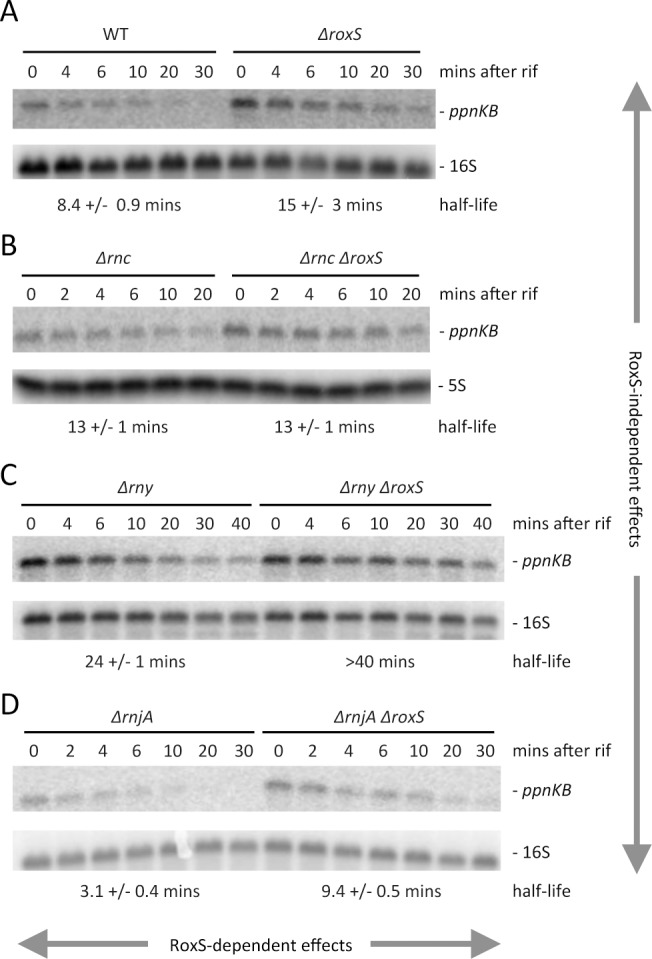
The stability of the ppnKB mRNA depends on RoxS, RNase III and RNase Y.(A) Northern blots of total RNA isolated from wild-type (WT) and ΔroxS strains (strain CCB485) probed for the ppnKB mRNA at times after addition of rifampicin (Rif) at 150 μg/mL. The blot was re-probed for 16S rRNA for normalization. Calculated half-lives are shown beneath the autoradiographs and are the average of 2 to 4 experiments, with standard errors as shown. (B) Same as in panel A using RNase III mutant strains CCB418 (Δrnc) and CCB515 (Δrnc ΔroxS). (C) Same as in panel A using RNase Y mutant strains CCB441 (Δrny) and CC558 (Δrny ΔroxS). (D) Same as in panel A using strains CCB434 (ΔrnjA) and CCB559 (ΔrnjA ΔroxS). RoxS-dependent effects of the different RNases are indicated by horizontal arrows and RoxS-independent effects of the different RNases by vertical arrows.